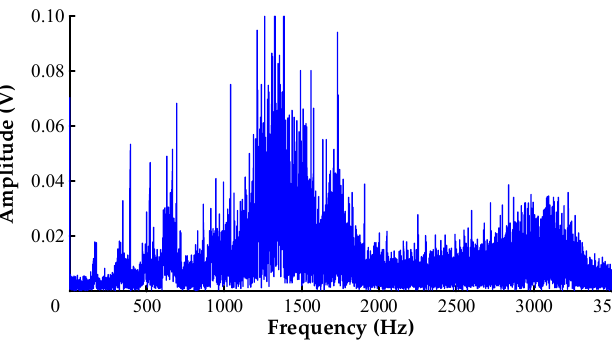
Figure 8. Signal spectrogram diagram under severe wear state. The time-frequency diagram under severe wear condition is obtained by STFT. The k-order signal component is obtained by ACMP, and the accurate instantaneous frequency is obtained by SCT. The results are shown in Figure 9.